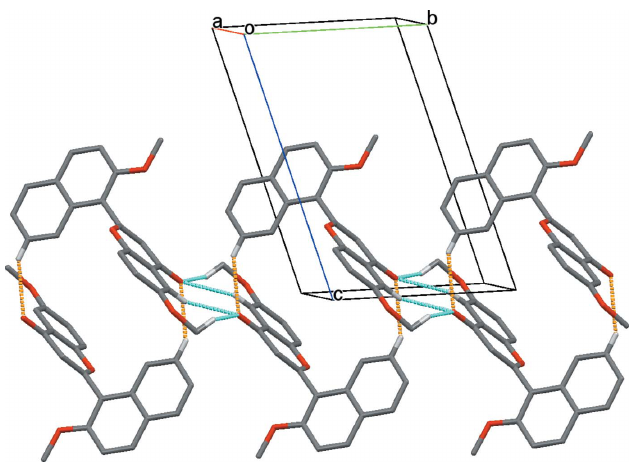
Figure 4 A partial view of the crystal structure of the title compound showing